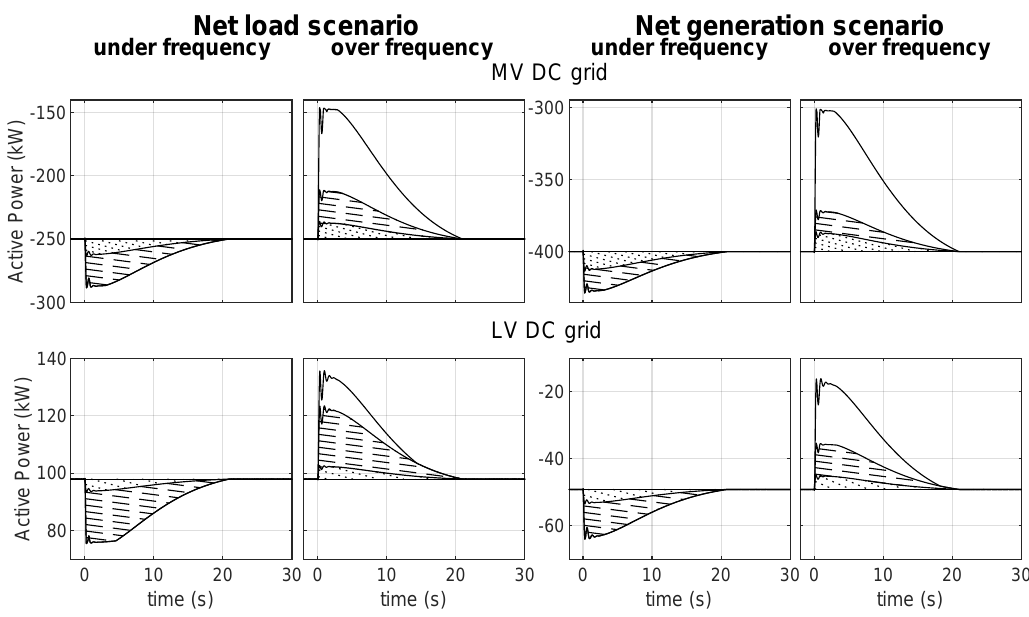
Figure 20. Active power consumption variation in DC grids due to load voltage sensitivity (dotted area), controllable EV charging (dashed area) and controllable PV generation (white area). Positive values correspond to power